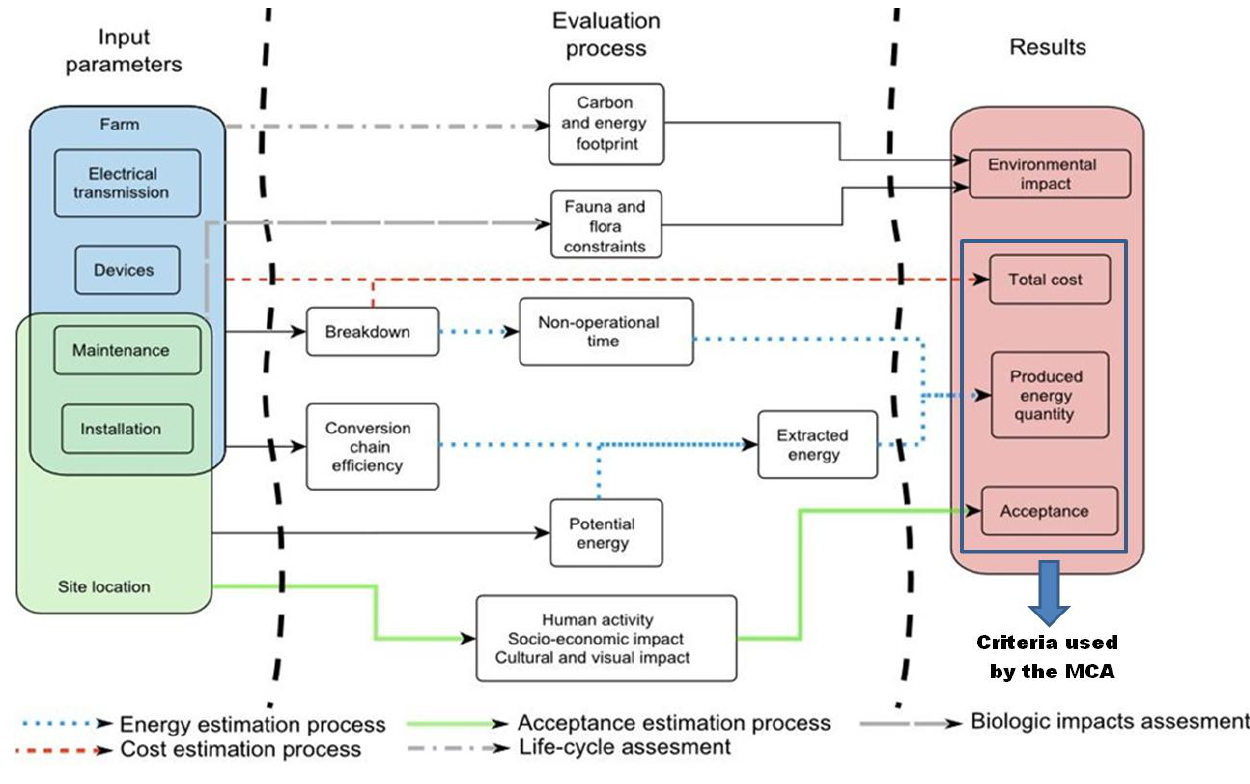
Figure 1. Multi-criteria approach: